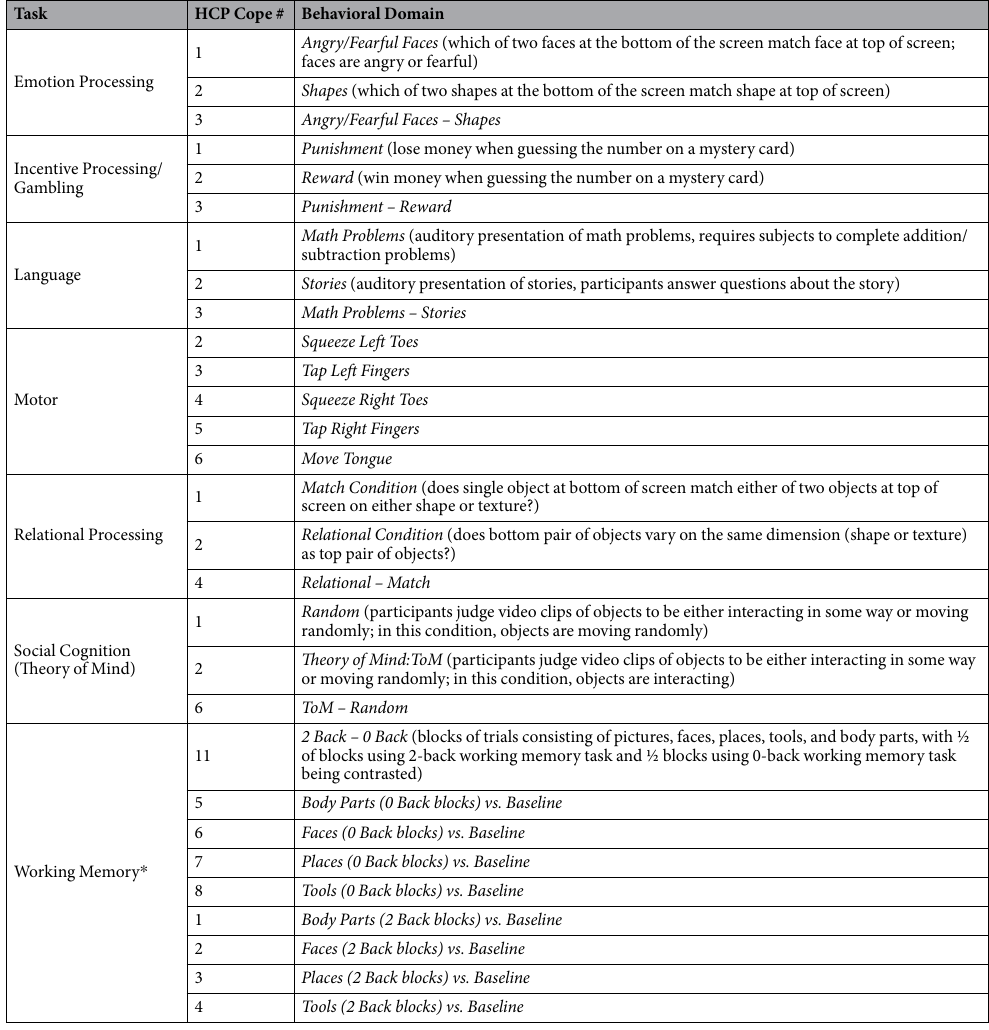
Table 1. COPES from each task that were used for the ICA and to estimate network activation shown in Figure 2. * For the ICA, working memory contrasts that averaged 0 Back and 2 Back blocks together for each stimulus type were used (COPEs 15–18), but the COPEs for 0 Back and 2 Back blocks relative to baseline were used to analyze network activation to facilitate